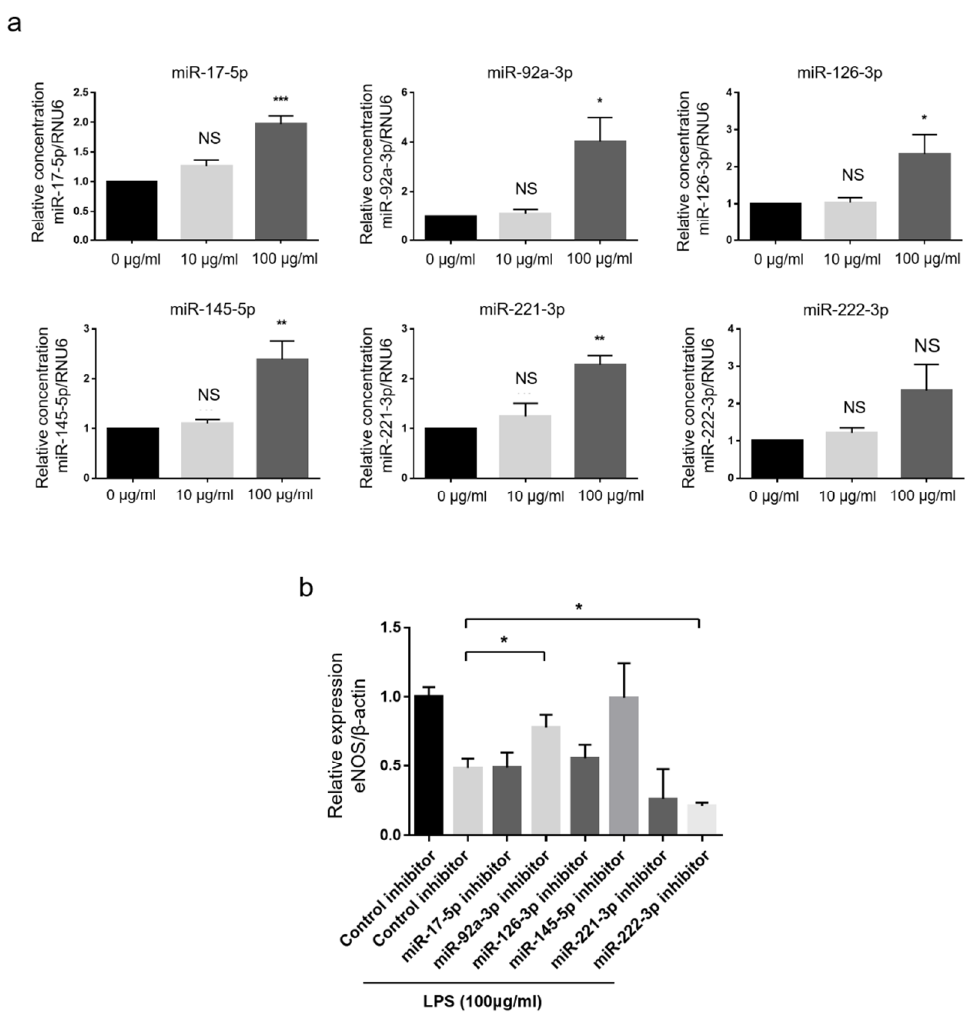
Figure 5. Role of miR modulation in eNOS protein expression in hCAECs treated with the vasculotoxic stimuli, LPS. ( A ) Relative concentration of miR-17-5p, miR-92a-3p, miR-126-3p, miR-145-5p, miR-221-3p, and miR-222-3p in hCAECs according to LPS concentration ( n = 3). ( B ) Densitometry of eNOS after transfection of each anti-miR-17-5p, anti-miR-92a-3p, anti-miR-126-3p, anti-miR-145-5p, anti-miR-221-3p, and anti-miR-22-3p ( n = 4). One-way analysis of variance was applied and data are presented as mean ± standard deviation. * Indicates p < 0.05, ** indicates p < 0.01, and *** indicates p < 0.001 compared to the control group with LPS treatment. eNOS, endothelial nitric oxide synthase; hCAECs, human coronary artery endothelial cell; LPS, lipopolysaccharide; miR, microRNA; ns, not significant